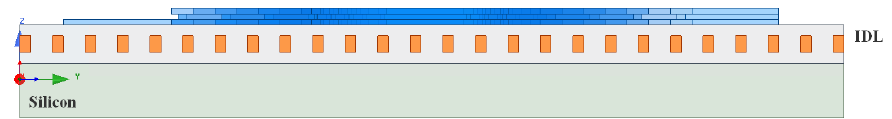
Figure 7. Side view of an inductor containing only one layer of DMFs.